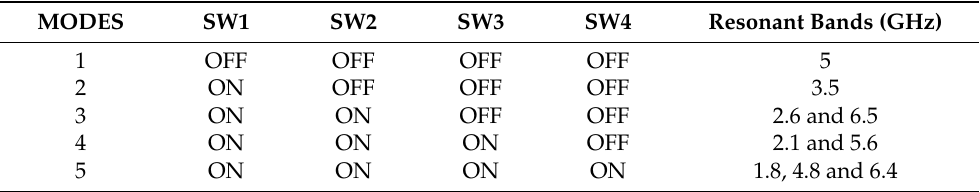
Table 2. Conditions of the PIN diodes for various resonant bands. MODES